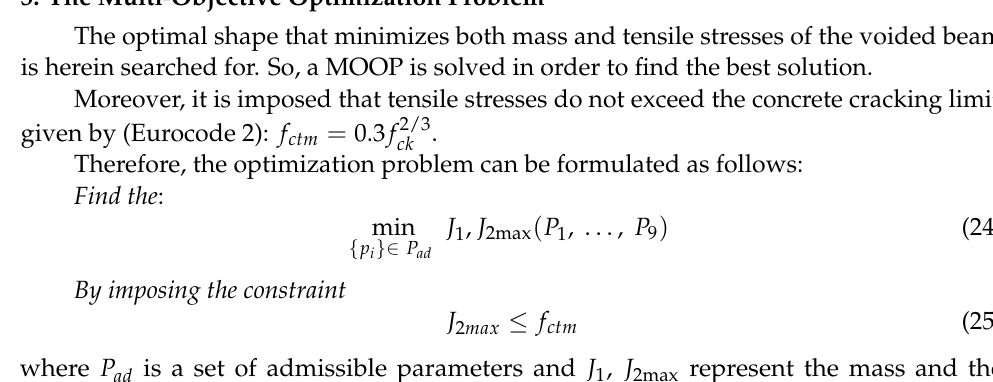
Figure 17. Tension (blue) (Sig1-Val) and compression (red) (Sig2-Val) path in the voided beam.